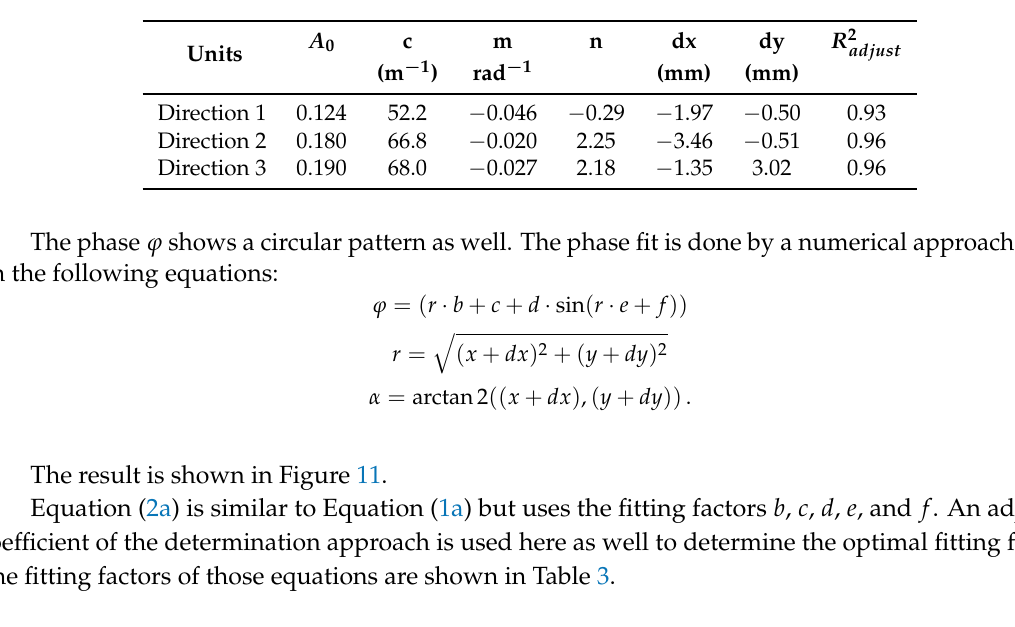
Table 2. Fit results amplitude